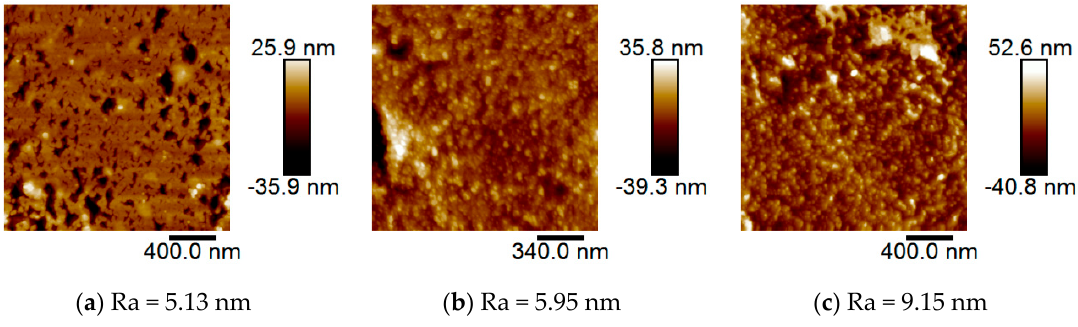
Figure 9. Two-dimensional atomic force microscope (AFM) images of three colored fluorite crystals: ( a ) CF; ( b ) GF; and ( c ) PF. ( a ) CF; ( b ) GF; and ( c ) PF.